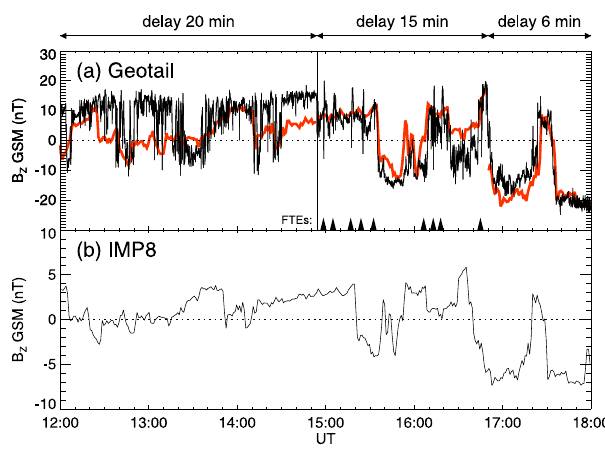
Fig. 4. The B z GSM component of the magnetic field measured at (a) Geotail (black line) and (b) IMP-8. The IMP-8 data has also been plotted in red in panel (a), magnified by a factor of three and subjected to three time delays of 20min, 15min and 6min, as indi- cated at the top of the